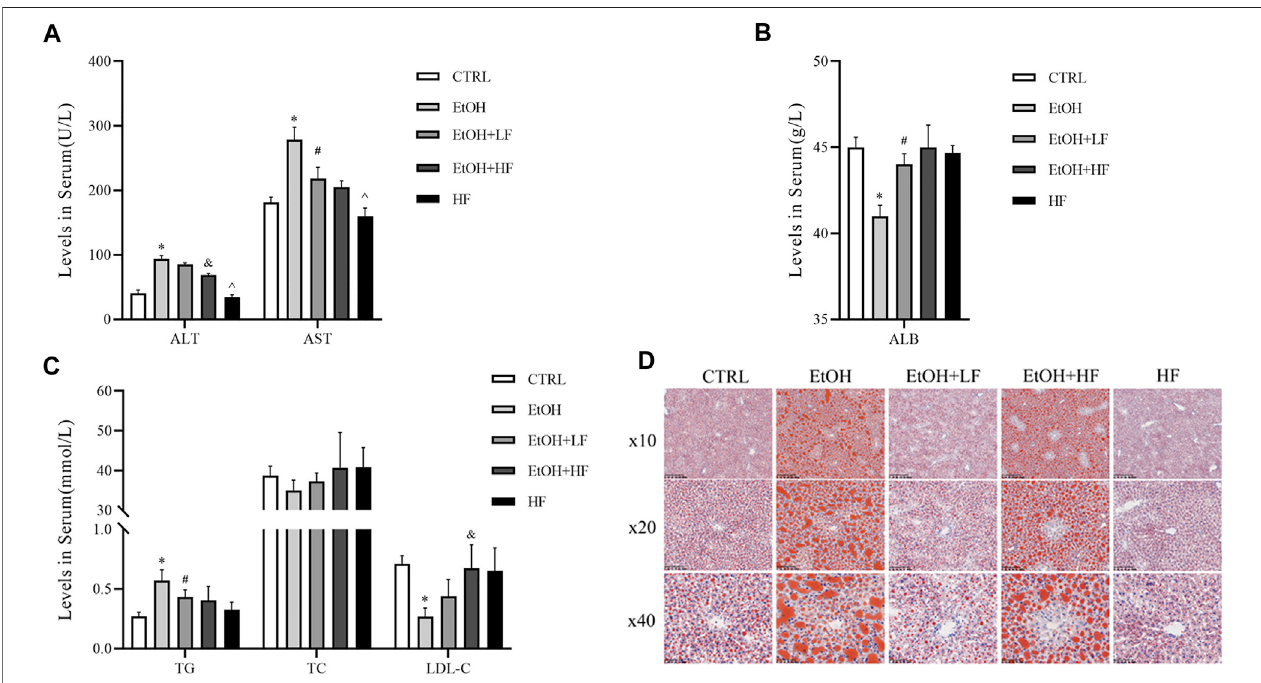
FIGURE 4 | Furfural alleviated ethanol-induced liver injury and lipid metabolism disorder in mice. (A) Serum alanine transaminase (ALT), aspartate transaminase (AST)levels. (B) SerumALBlevels. (C) Serumlipidlevels. (D) OilredOstainingoflivertissues.Thedataareexpressedasthemeans±SEM.* p < 0.05,comparedwiththe CTRL group; # p < 0.05, compared with the EtOH group; & p < 0.05, compared with the EtOH + LF group; ^ p < 0.05, compared with the EtOH + HF